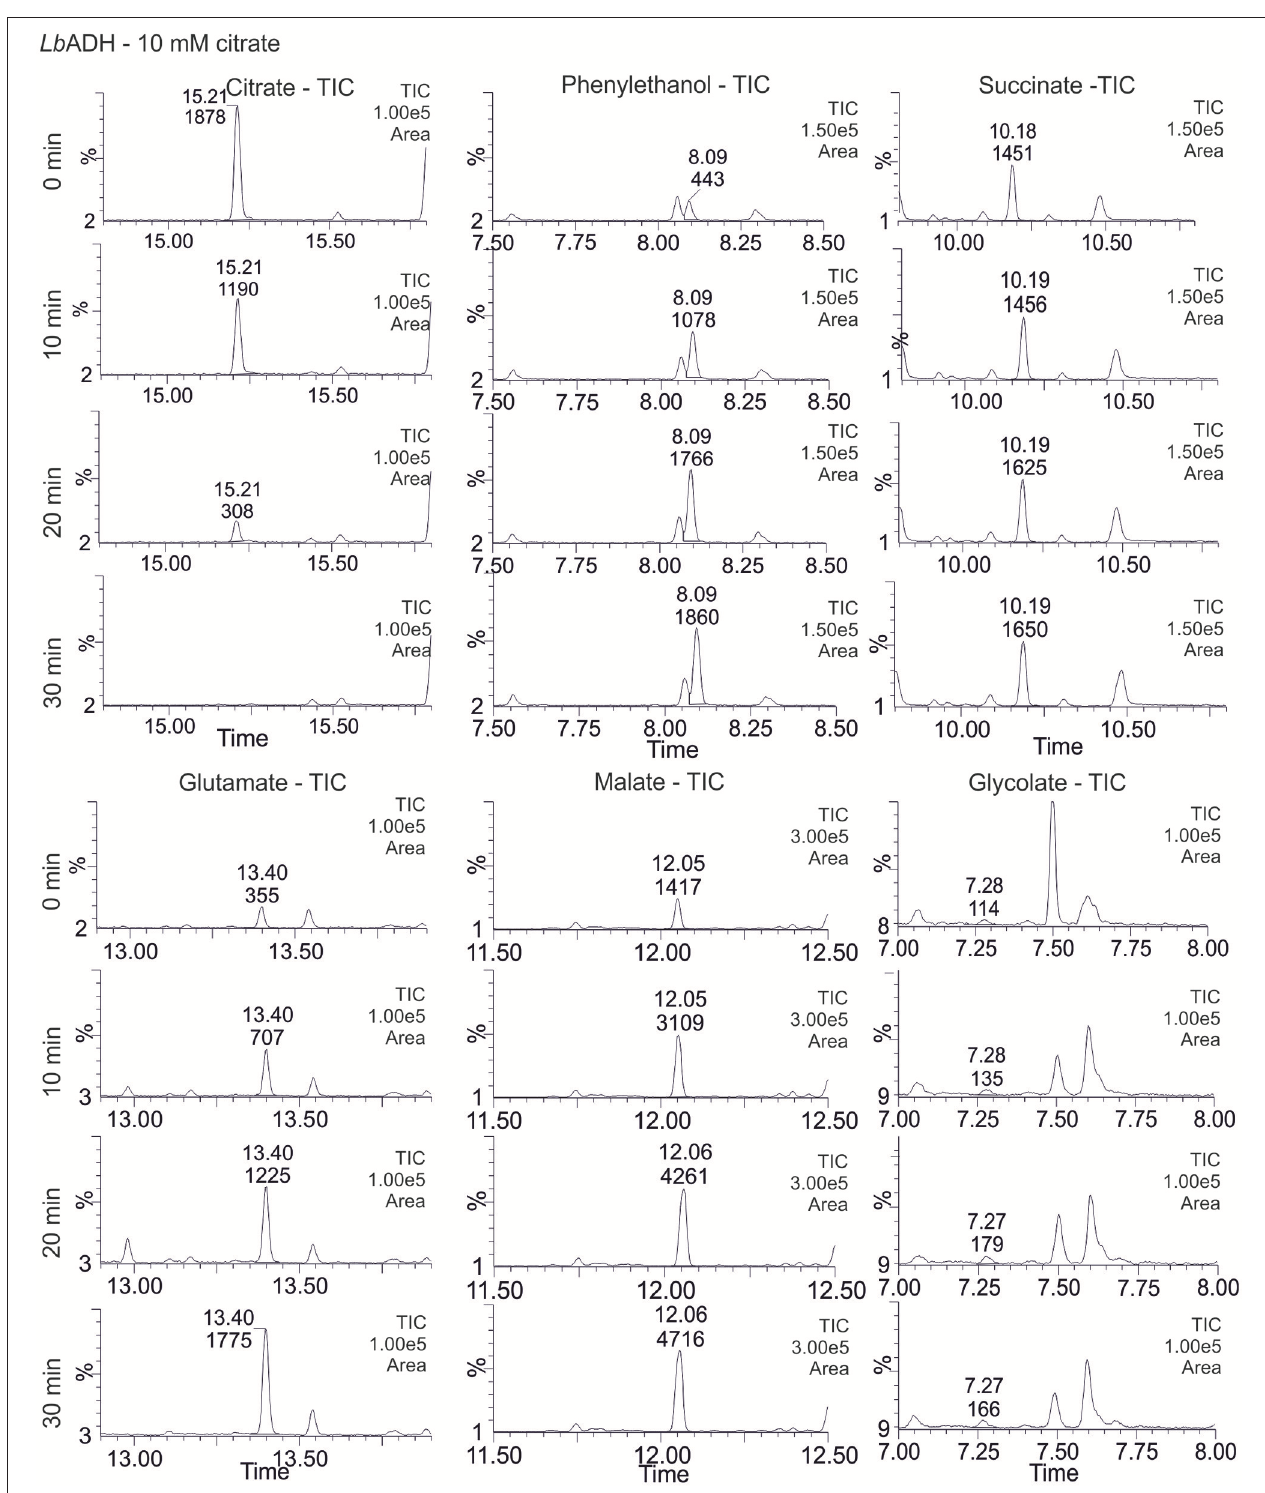
FIGURE 6 | Total ion chromatograms (TIC) of selected TCA cycle intermediates. Relative concentration changes during the isotopic labeling experiment with [1,5- 13 C]citrate in Lactobacillus brevis alcohol dehydrogenase ( Lb ADH) crude cell extract are shown (for corresponding mass spectrometic chromatogram of all detected metabolites see Supplementary S2.1 and for corresponding results of KRED1- Pglu see Supplementary S2.3 ).